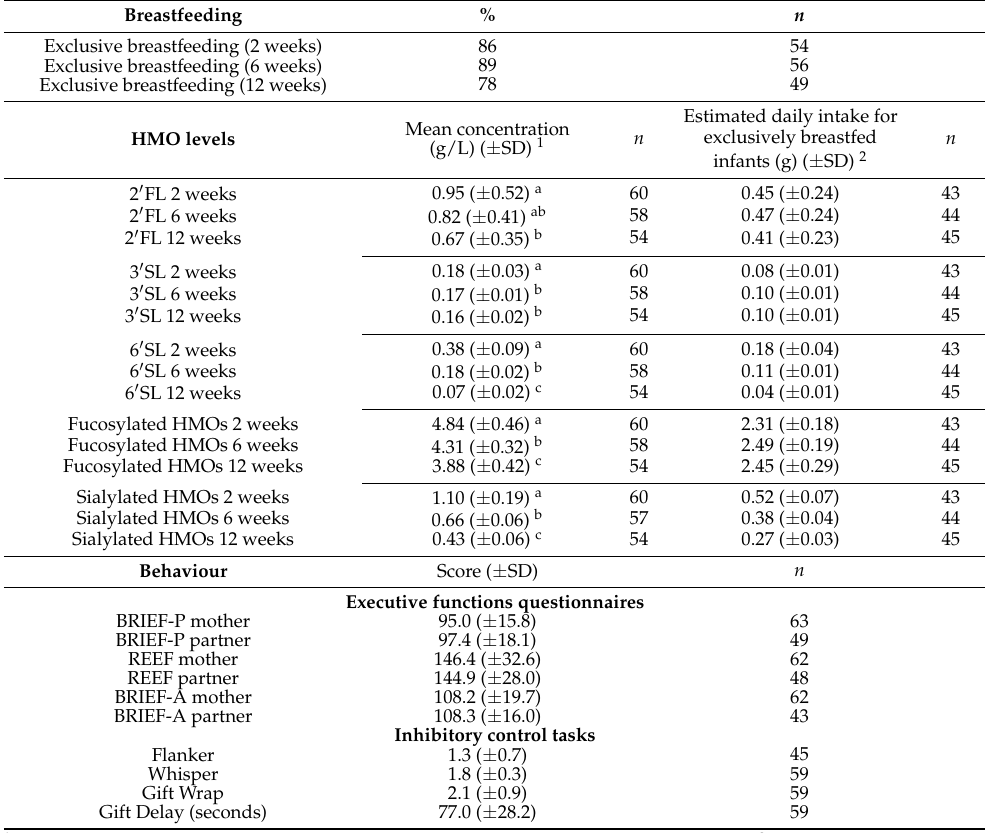
Table 2. Descriptive statistics of measured variables: breastfeeding, HMO levels, executive functions, and inhibitory